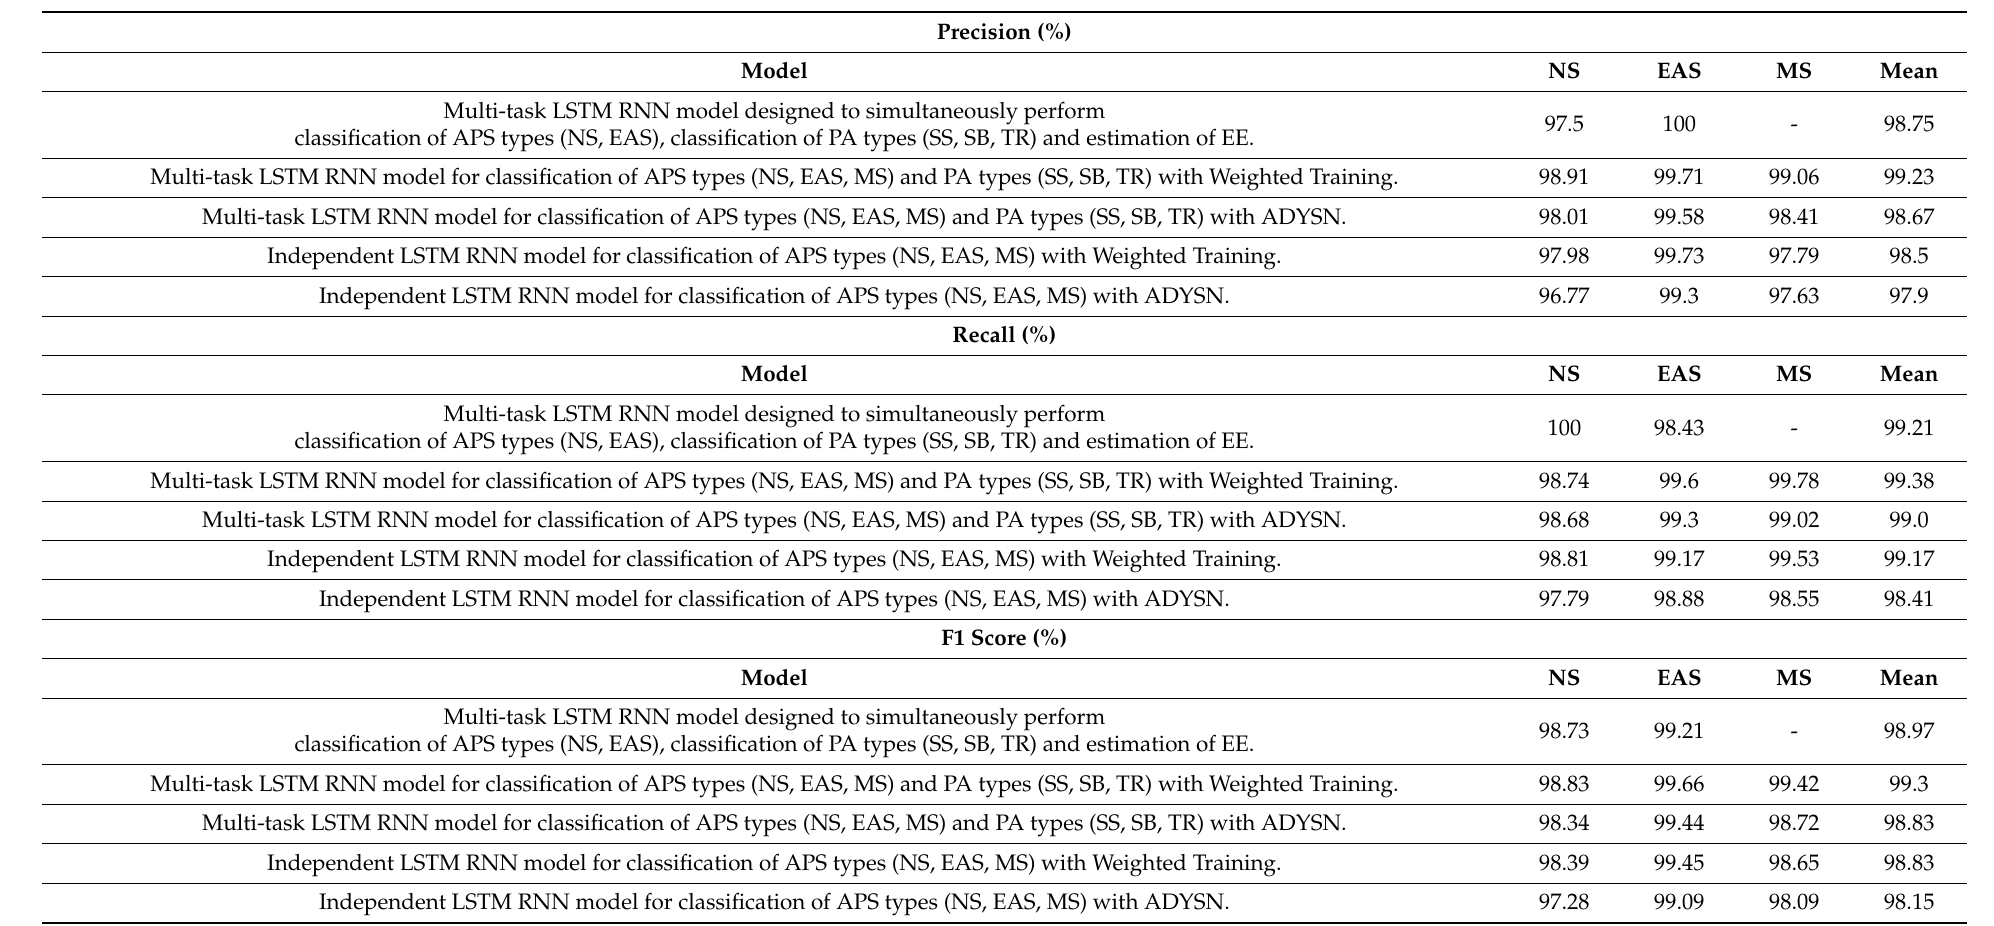
Table A2. Precision, Recall, and F1 score for APS Classification (LSTM